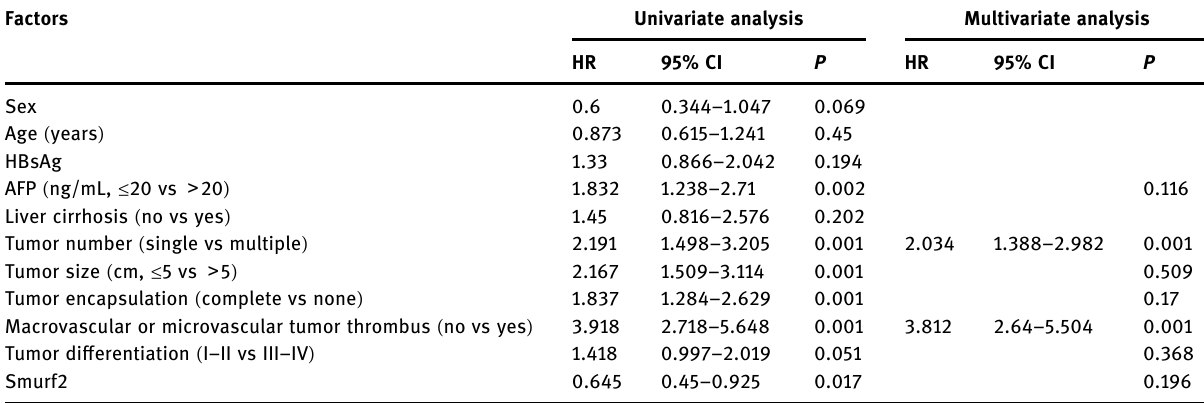
Table 3: Univariate and multivariate analyses of clinicopathological factors for DFS in HCC patients Factors Univariate analysis Multivariate